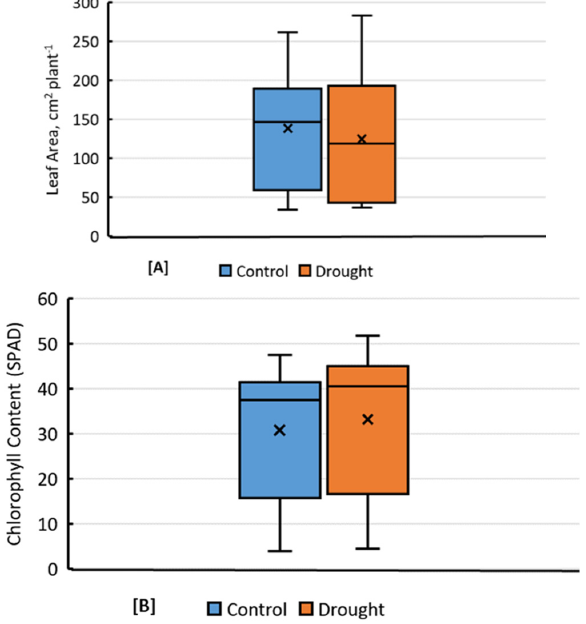
Figure 1. ( A , B ) Comparison of 74 rice genotypes for ( A ) leaf area and ( B ) chlorophyll content (SPAD units) traits under drought and controlled conditions observed 37 days after sowing.